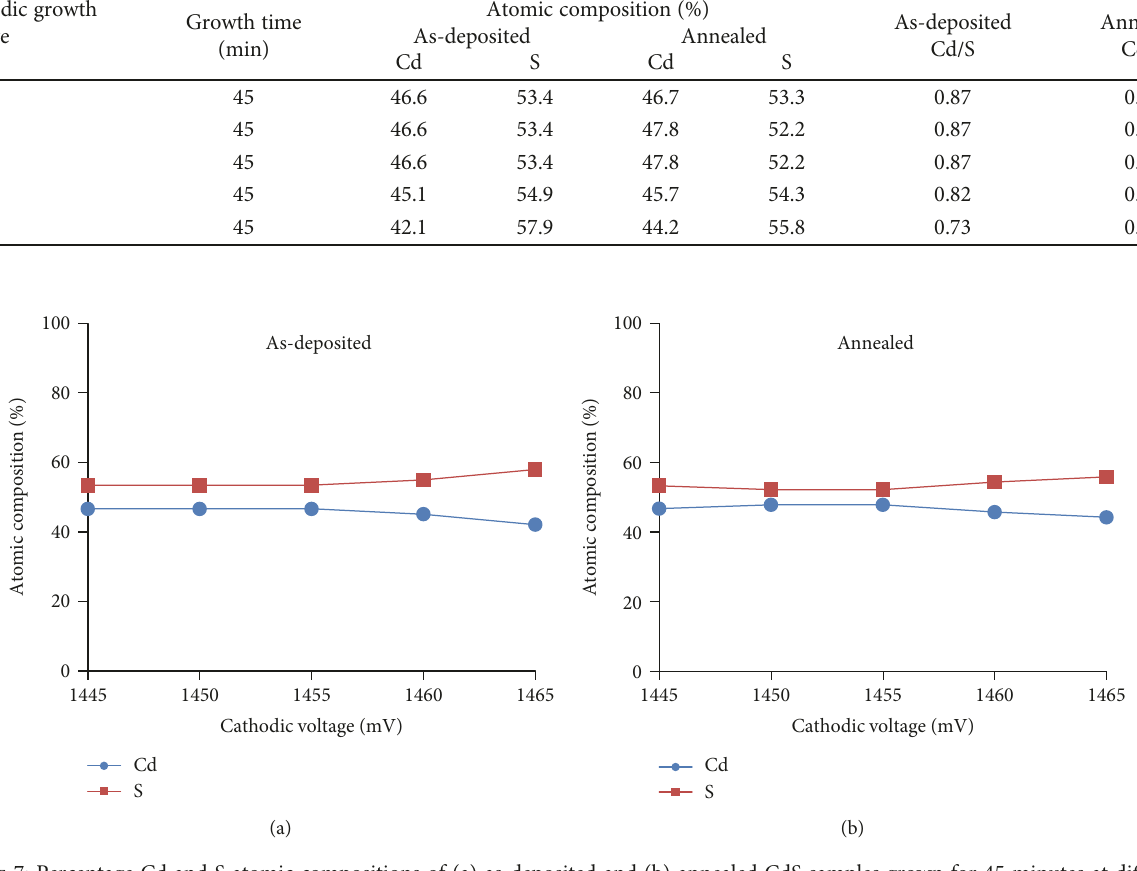
Figure 7: Percentage Cd and S atomic compositions of (a) as-deposited and (b) annealed CdS samples grown for 45 minutes at di ff erent cathodic